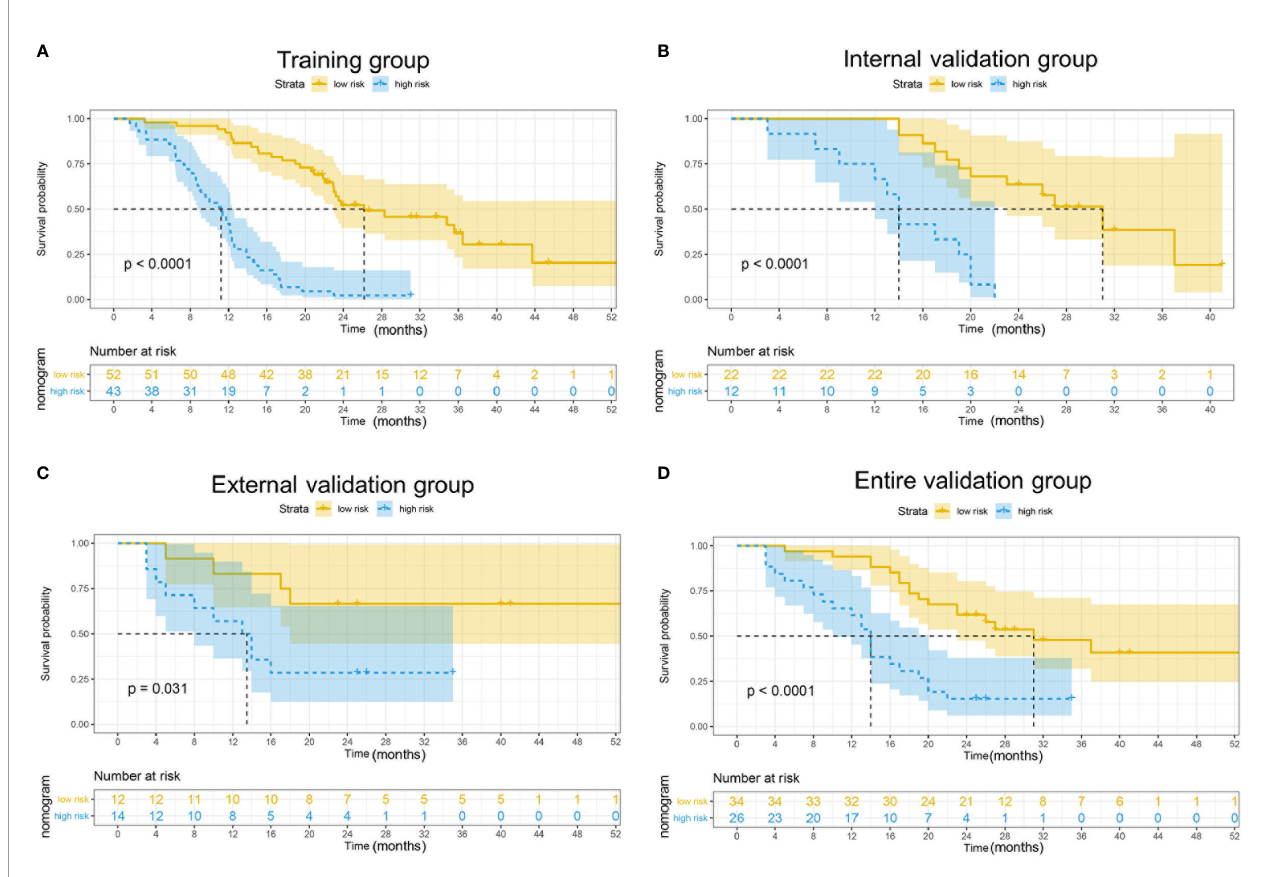
FIGURE 6 | Kaplan – Meier curves for 2-year OS in the training, external validation, internal validation and entire validation groups. (A) The survival curves in the training group according to nomogram. The OS probability was signi fi cantly worse in the high-risk group compared to the low-risk group (p < 0.0001). (B) The survival curves in the external validation group according to nomogram. The OS probability was signi fi cantly worse in the high-risk group compared to the low-risk group (p = 0.031). (C) The survival curves in the internal validation group according to nomogram. The OS probability was signi fi cantly worse in the high-risk group compared to the low-risk group (p < 0.0001). (D) The survival curves in the entire validation group according to nomogram. The OS probability was signi fi cantly worse in the high-risk group compared to the low-risk group (p <